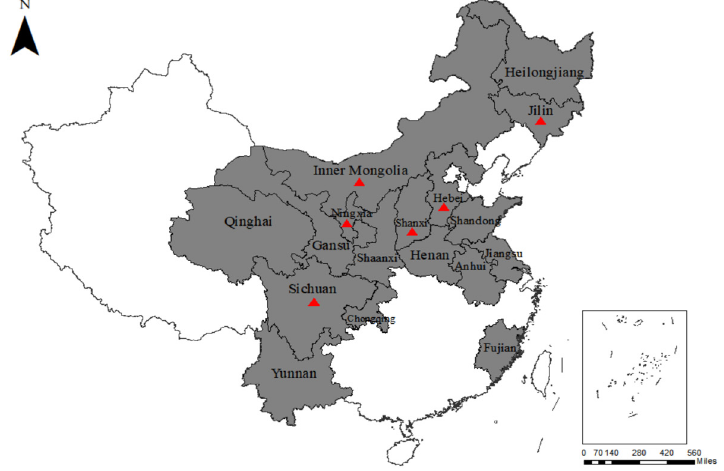
Figure 1. Map of China displaying the areas of sample collection. The 17 sampled regions are indicated in gray. The red triangles ( ) represent the sampling areas that tested positive for BPIV3.